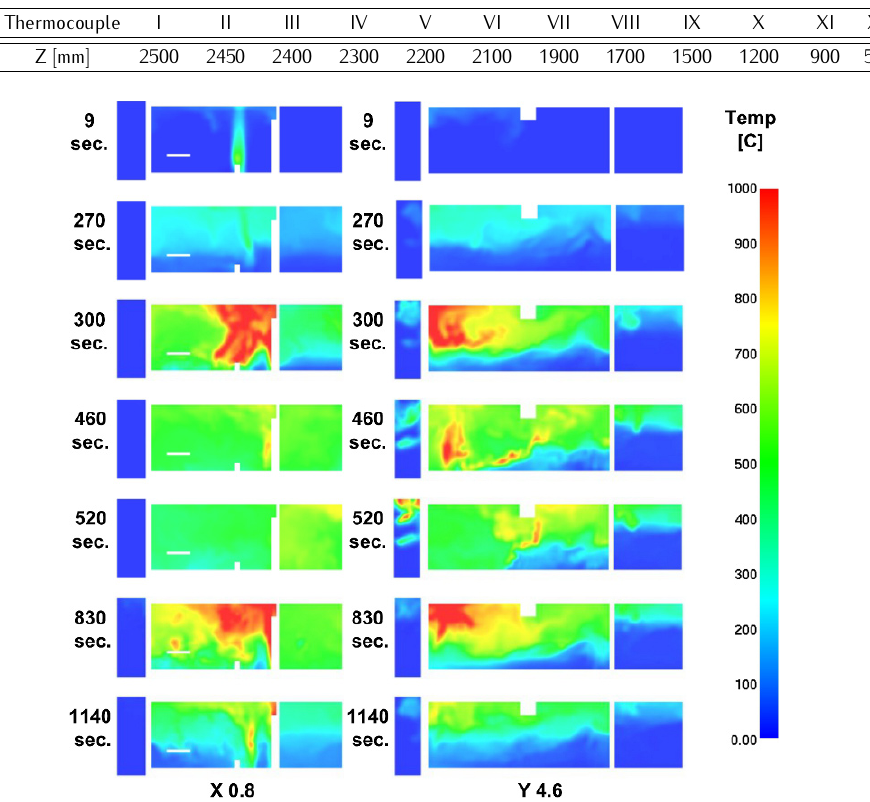
Table 7. Numerical thermocouples Z-axis coordinates.